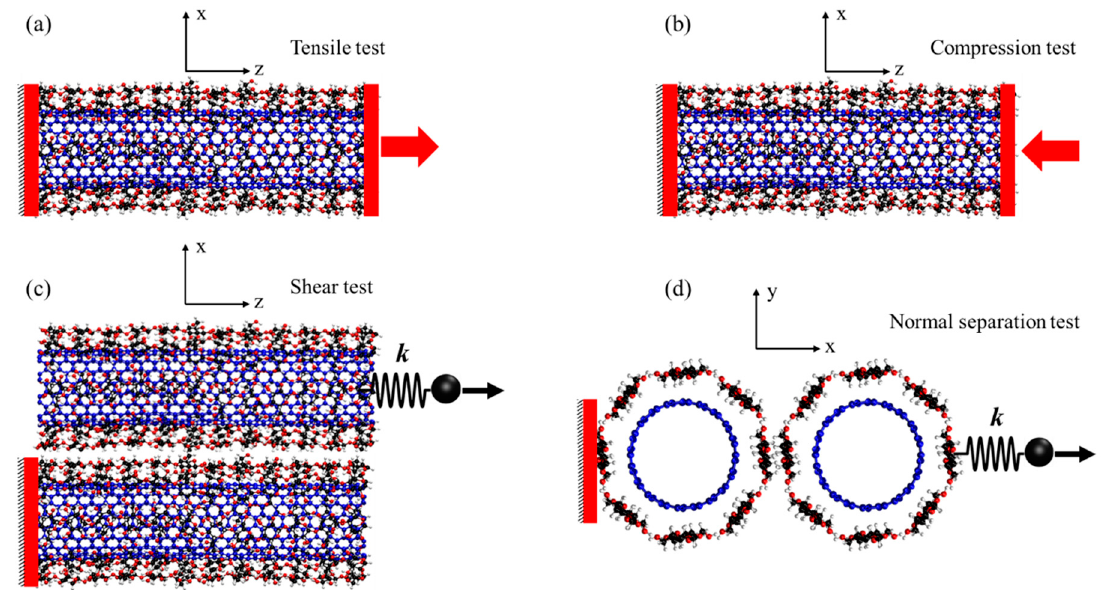
Figure 3. Mechanical and surface energy tests for calculating mechanical performance, shear force, and adhesion energy of fibers. ( a ) Tensile test, ( b ) compression test, ( c ) shear test, and ( d ) normal test for adhesion energy.